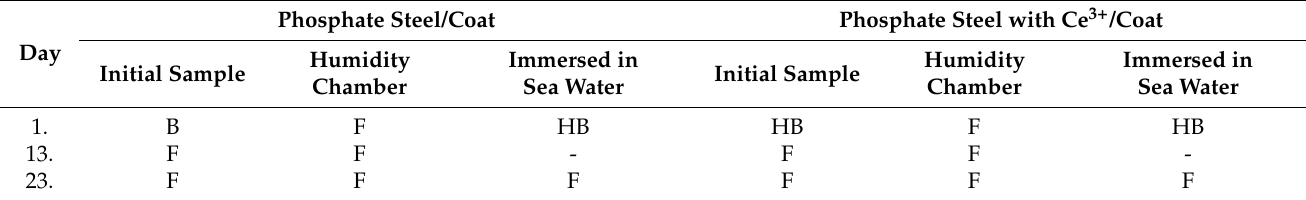
Table 9. Hardness value for medium-hard coatings exposed to different corrosion conditions.